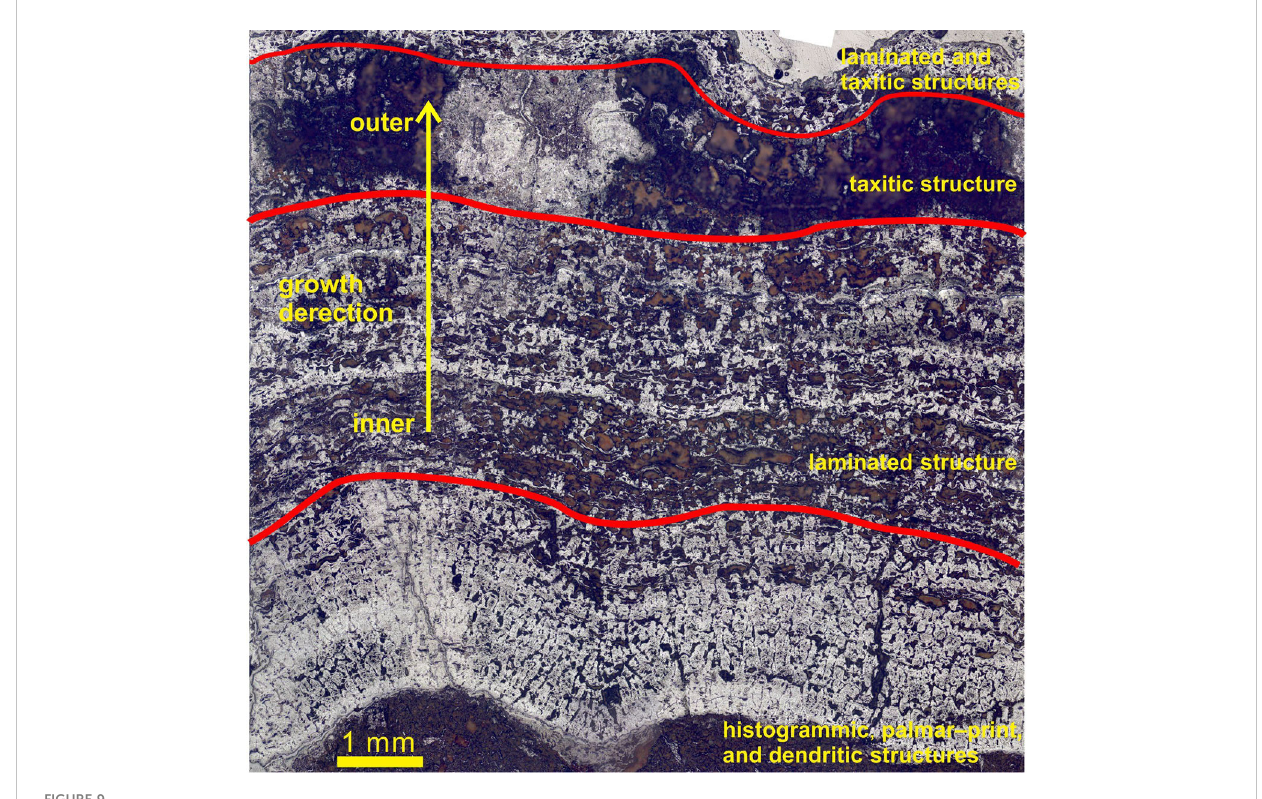
FIGURE 9 Microstructure growth of sample